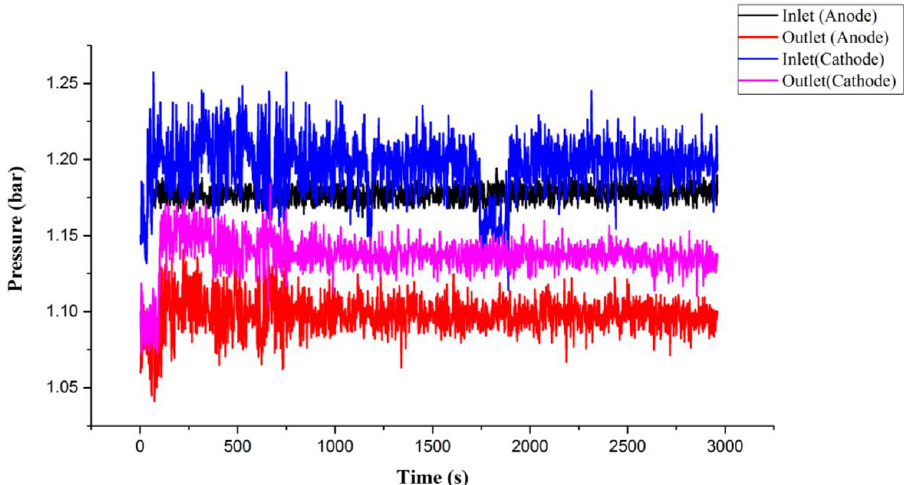
Figure 12. Pressure variation of HT-PEMFCs at different